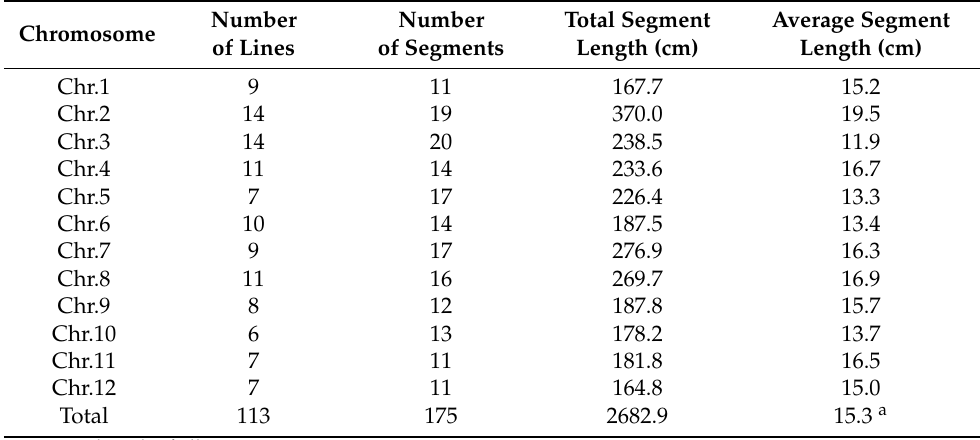
Figure 2. Schematic of the development of CSSLs carrying N22 chromosome segments in 9311 genetic background. Table 2. Substitution of N22 segments in